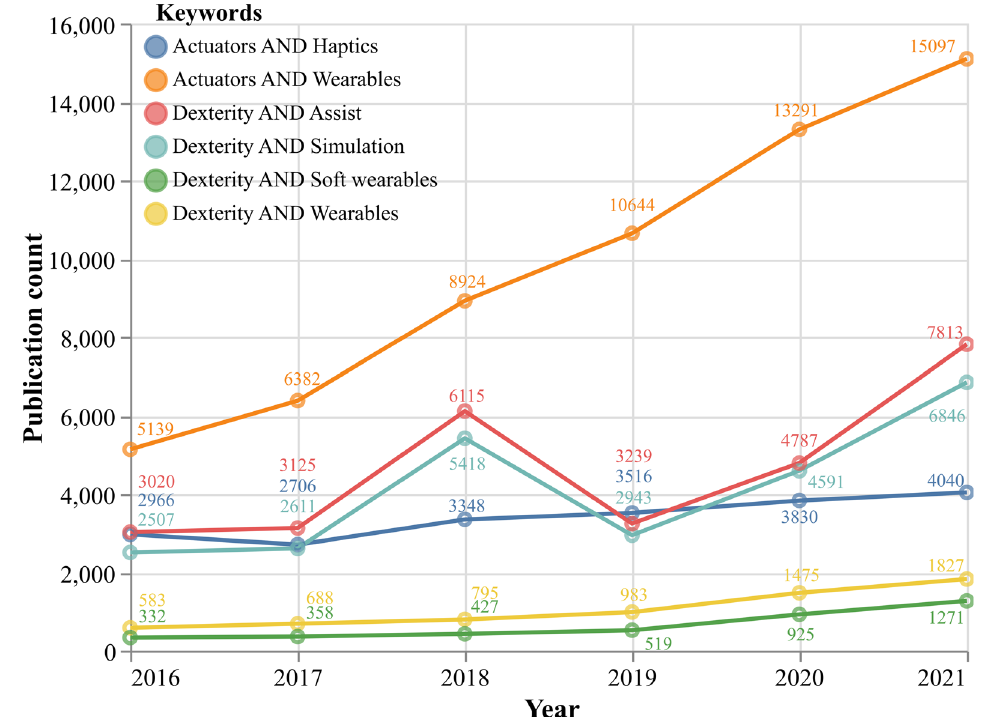
Fig. 1 Number of publications for the searched keywords during the selected period